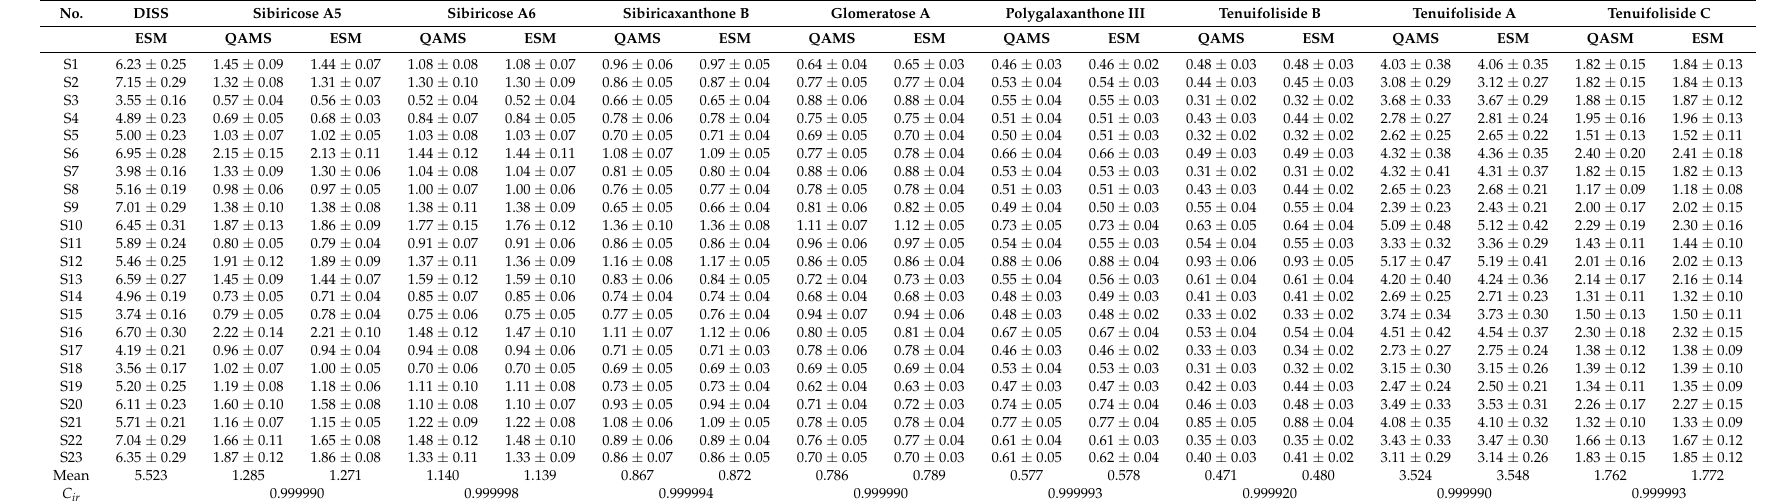
Table 3. The concentrations of nine components of P. tenuifolia by the external standard method (ESM) and the quantitative analysis of multi-components by a single marker (QAMS) method (mg/g, n = 3) 1